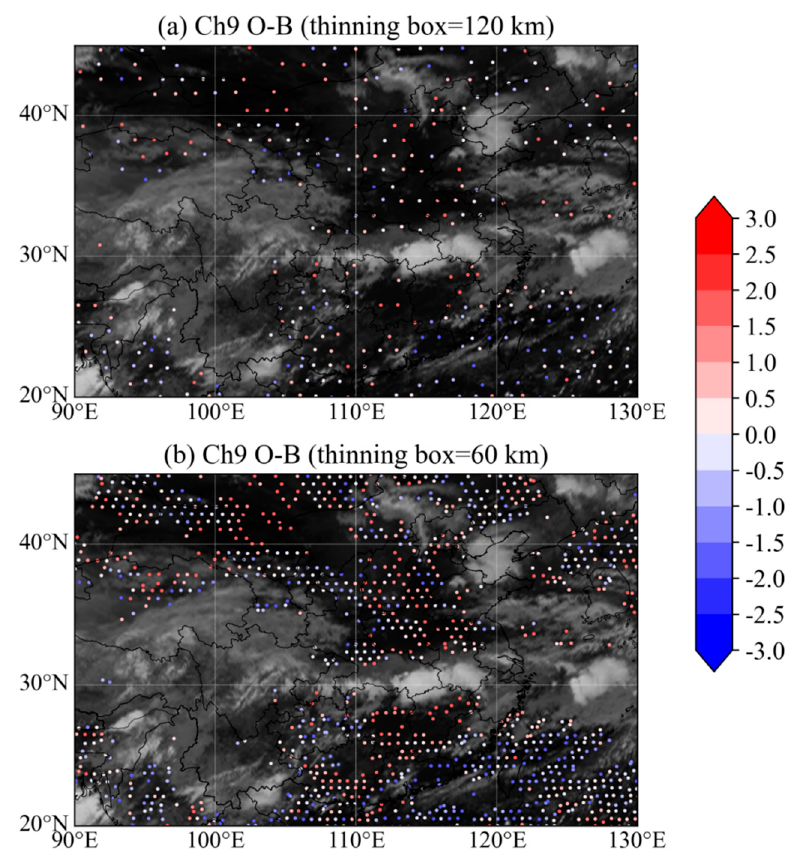
Figure 3. Spatial distributions of the bias-removed O − B of the assimilated AGRI channel 9 data points at 0000 UTC on 5 July 2020, with ( a ) 120 km and ( b ) 60 km thinning grids. The backgrounds are the brightness temperatures of the AGRI 10.7 μ m IR channel.